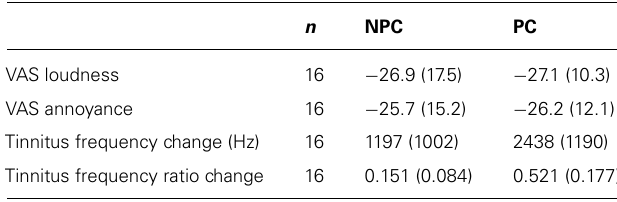
Table 1 | Clinical characteristics of NPC and PC groups, mean (SD). n